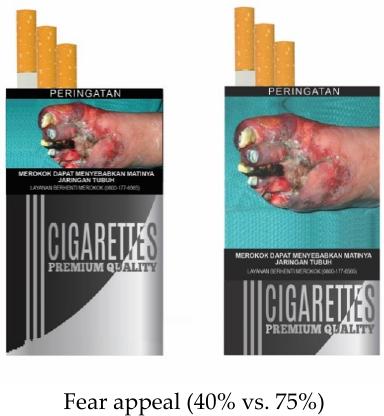
Figure 2. Experiment materials.